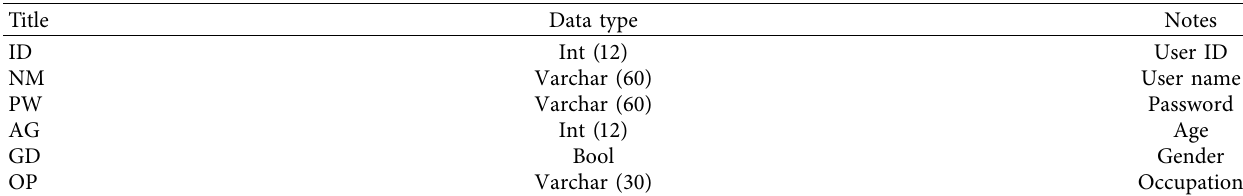
Figure 5: System E-R diagram. Table 2: User information database